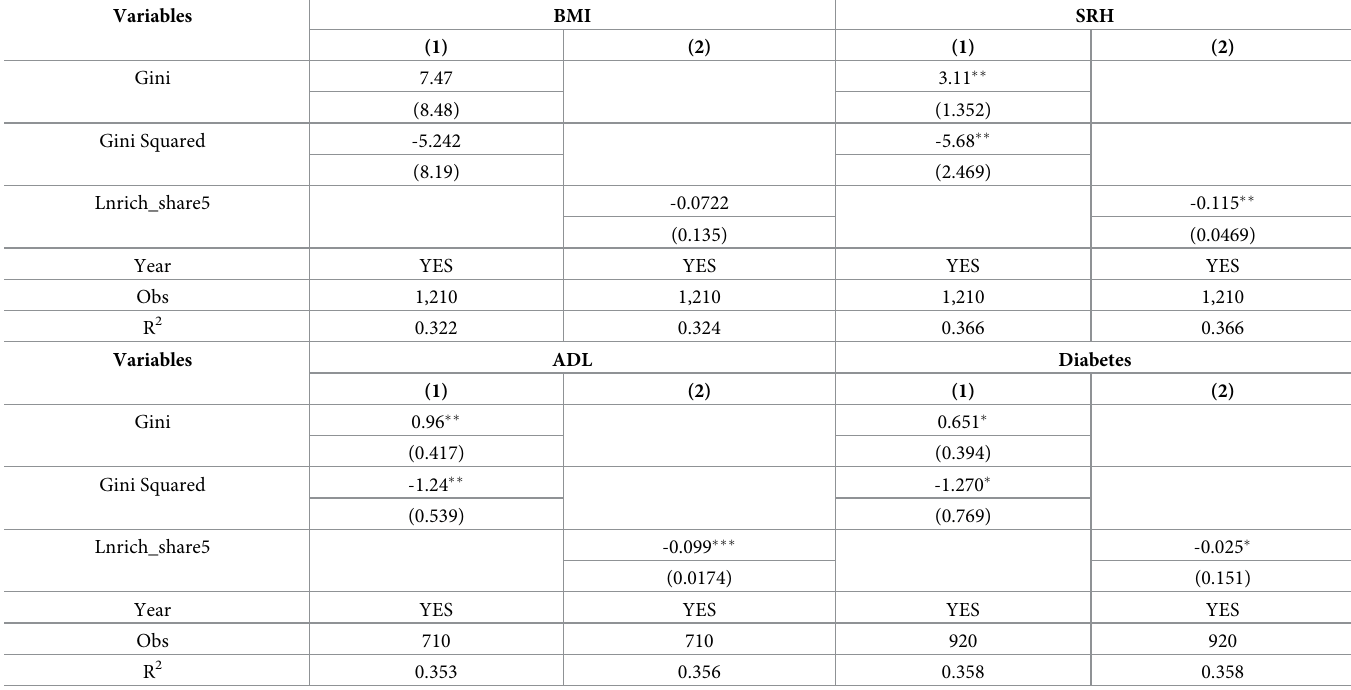
Table 14. Estimates from balanced panel